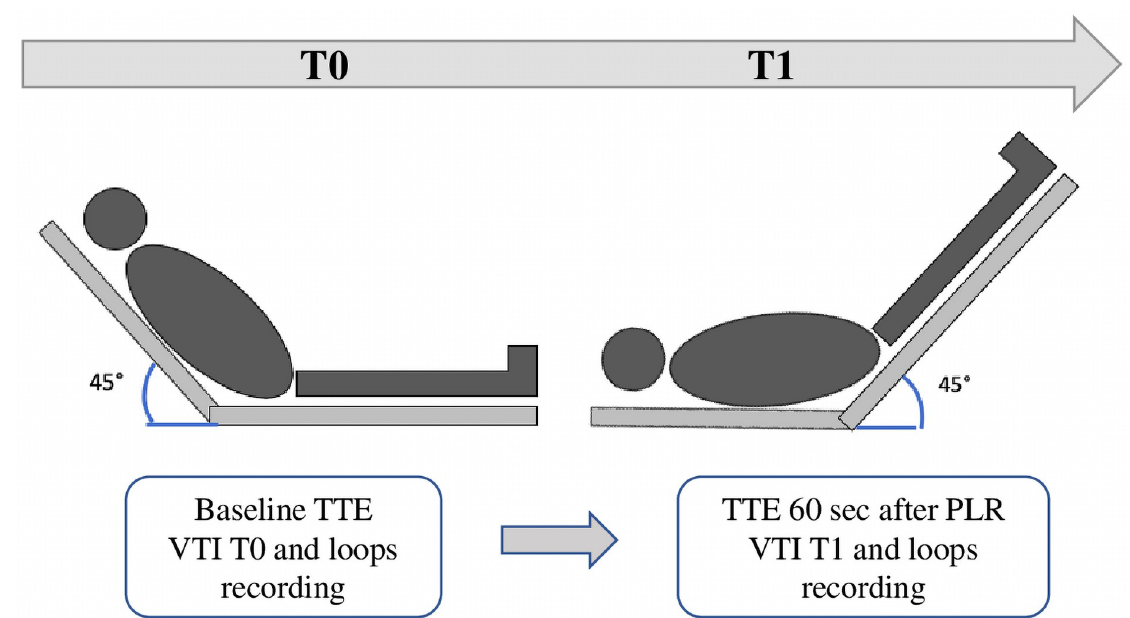
Fig 1. Time-point schedule and echocardiography protocol. TTE: trans-thoracic echocardiography; VTI: velocity time integral; PLR: passive leg raising.